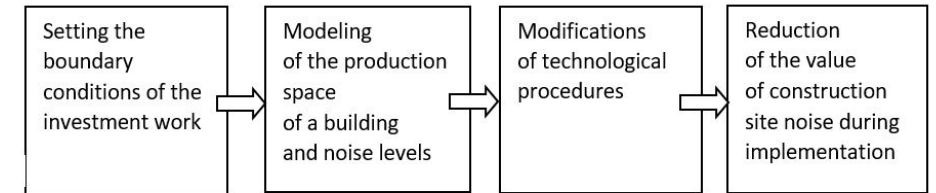
Figure 1. Reducing the value of construction site noise by modelling the production area of construction site and modifica- tions of technological procedures during construction.